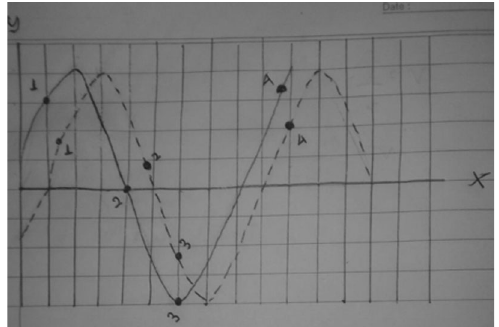
FIG. 7. Ivan drew the next wave profile after a complete wavelength.